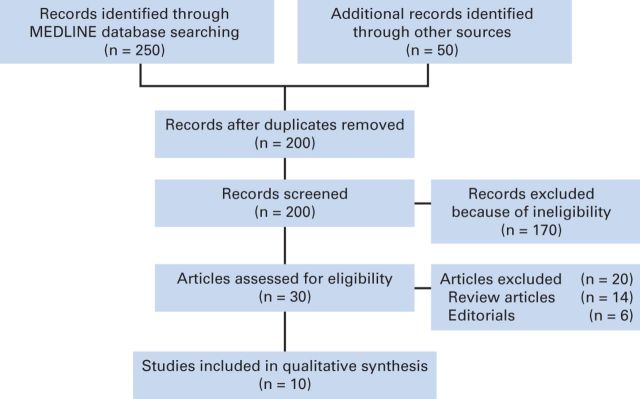
Flowchart of study selection procedure.